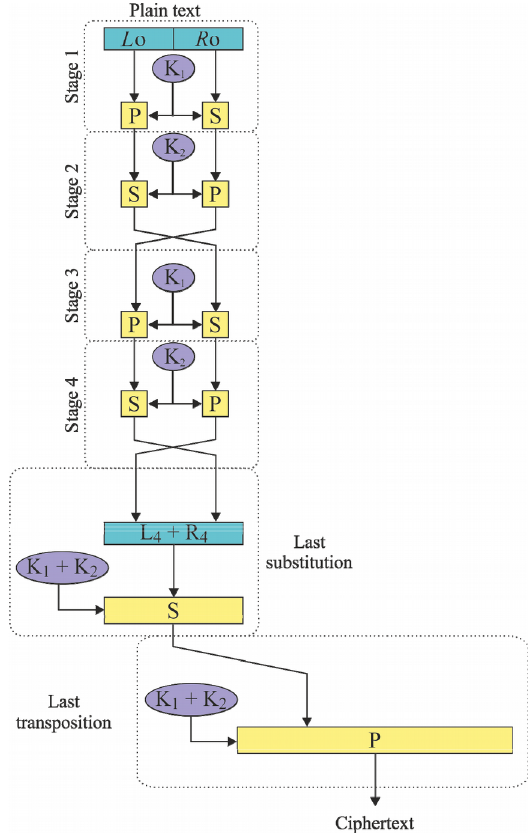
Figure 2. Azrael algorithm encryption